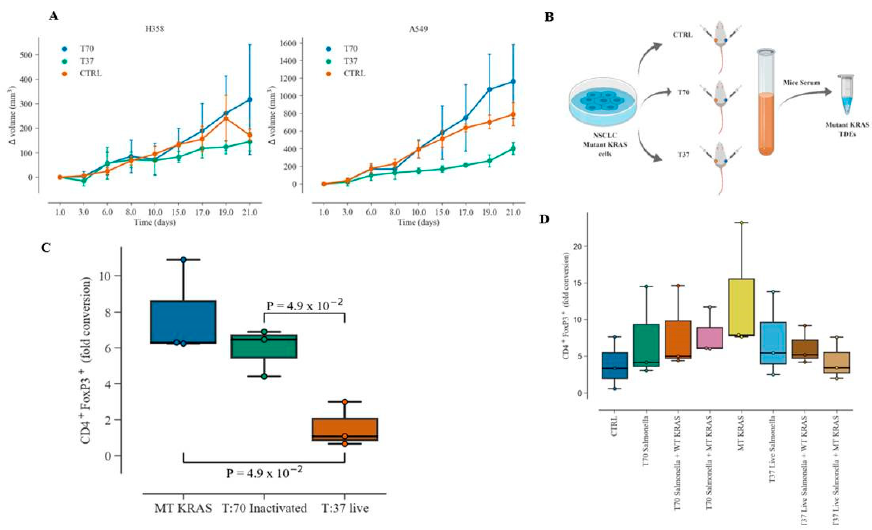
Figure 5. TDEs from mice harboring exponentially growing tumors convert T cells to Treg-like cells. Mouse xenografts with MT KRAS NSCLC cells harboring the G12D (A549 cells) or the G12C (H358 cells) KRAS mutations were created in NSG mice ( n = 12) to initiate a two-sided xenograft model. ( A ) Mice were randomly assigned to three groups: (1) control (CTRL) group, (2) infected with heat-inactivated Salmonella (T70) group, and (3) infected with live bioluminescent Salmonella typhimurium YS1646 (T37) group. ( B ) At day 21, mice were euthanized and exosomes were isolated. ( C ) Naïve CD4 + CD25 − T cells from donor PBMCs were treated with MT KRAS TDEs isolated from mice sera, with induced tumor, infected with heat-inactivated Salmonella (T70), or live bioluminescent Salmonella typhimurium. Fold conversion of naïve CD4 + CD25 − T cells to CD4 + FOXP3 + Treg-like cells was assessed by flow cytometry. ( D ) The in vitro e ff ect of live (37 ◦ C) or heat-inactivated (T70) bioluminescent Salmonella typhimurium on naïve CD4 + CD25 − T cells incubated with WT or MT KRAS TDEs was evaluated. The box plot for the three independent donor samples shows fold conversion to CD4 + and FOXP3 + and represents the interquartile range (IQR) where the horizontal line indicates the median. Whiskers